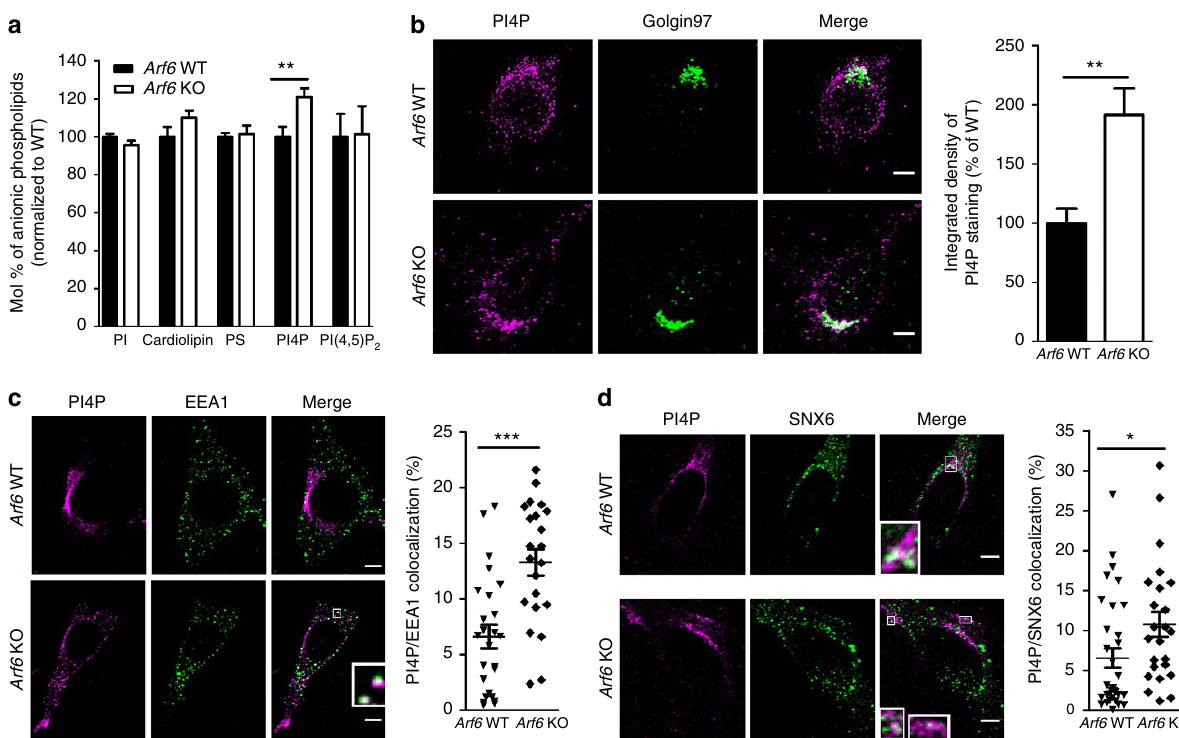
Figure 5 | PI4P is increased in Arf6 KO cells and accumulates in retromer-positive endosomes. ( a ) Bar diagram showing lipid levels in Arf6 WTand KO cells. Measurements were made by anionic exchange HPLC with suppressed conductivity detection, expressed in molar percentage of total anionic phospholipid measured and normalized to Arf6 WT levels. PI4P levels were increased in Arf6 KO cells (121 ± 5%, ± indicates s.e.m., n ¼ 9) compared with controls (100 ± 5%, n ¼ 9). ** P o 0.01 in Student’s t -test. ( b ) Left, representative confocal images of Arf6 WT and KO cells immunostained for PI4P (magenta) and Golgin97 (green). Scale bar, 5 m m. Right, normalized integrated densities of PI4P staining were increased in Arf6 KO cells (191 ± 23%, ± indicates s.e.m., n ¼ 27 cells, three experiments) compared to controls (100 ± 12%, n ¼ 22 cells, three experiments). ** P o 0.01 in t -test with Welch’s correction. ( c ) Left, representative confocal images of Arf6 WTand KO cells immunostained for PI4P (magenta) and EEA1 (green). Scale bar, 5 m m. Right, PI4P/EEA1 co-localization levels in Arf6 WT (7 ± 1%, ± indicates s.e.m., n ¼ 25 cells, three experiments) and KO cells (13 ± 1%, n ¼ 22 cells, three experiments). *** P o 0.001 in Student’s t -test. ( d ) Left, representative confocal images of Arf6 WT and KO cells immunostained for PI4P (magenta) and SNX6 (green). Scale bar, 5 m m. Right, PI4P/SNX6 co-localization levels in WT (7 ± 1%, ± indicates s.e.m., n ¼ 33 cells, three experiments) and KO